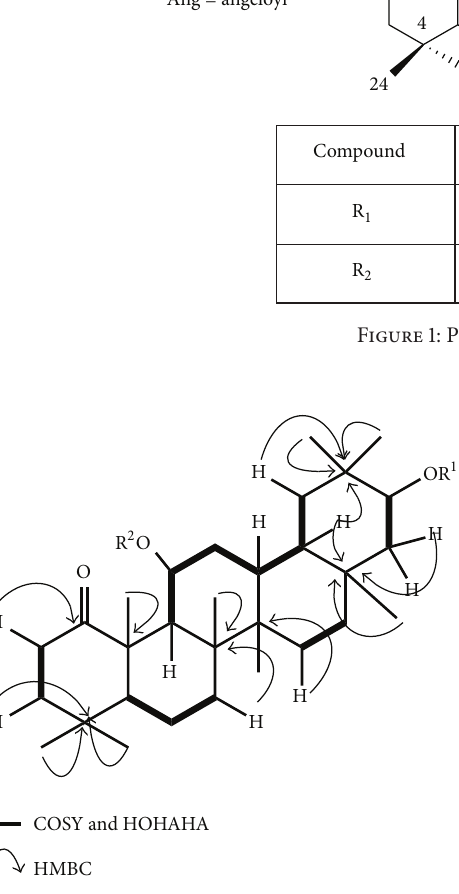
Figure 2: COSY and HOHAHA; HMBC interaction in compounds 1 – 5 .